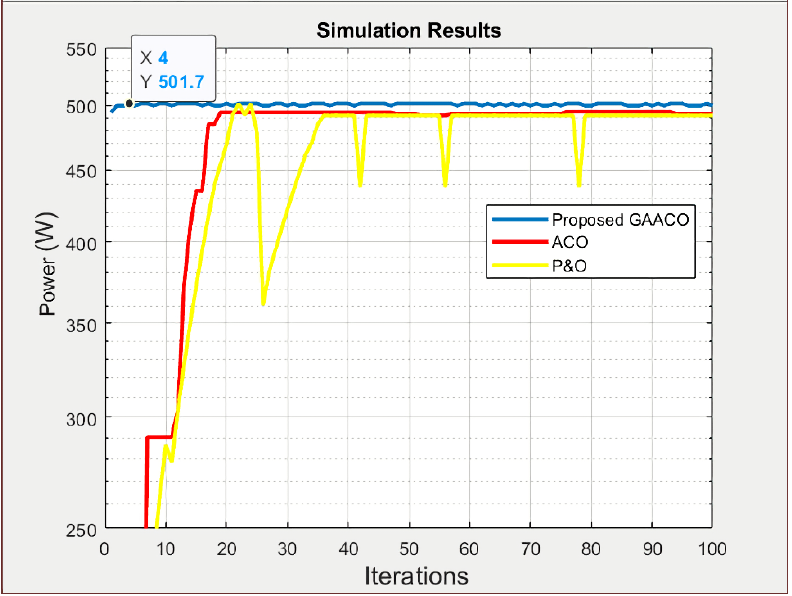
Figure 12. Simulation results of the proposed GA-ACO MPPT compared with P&O and conventional ACO MPPTs in Case 4.